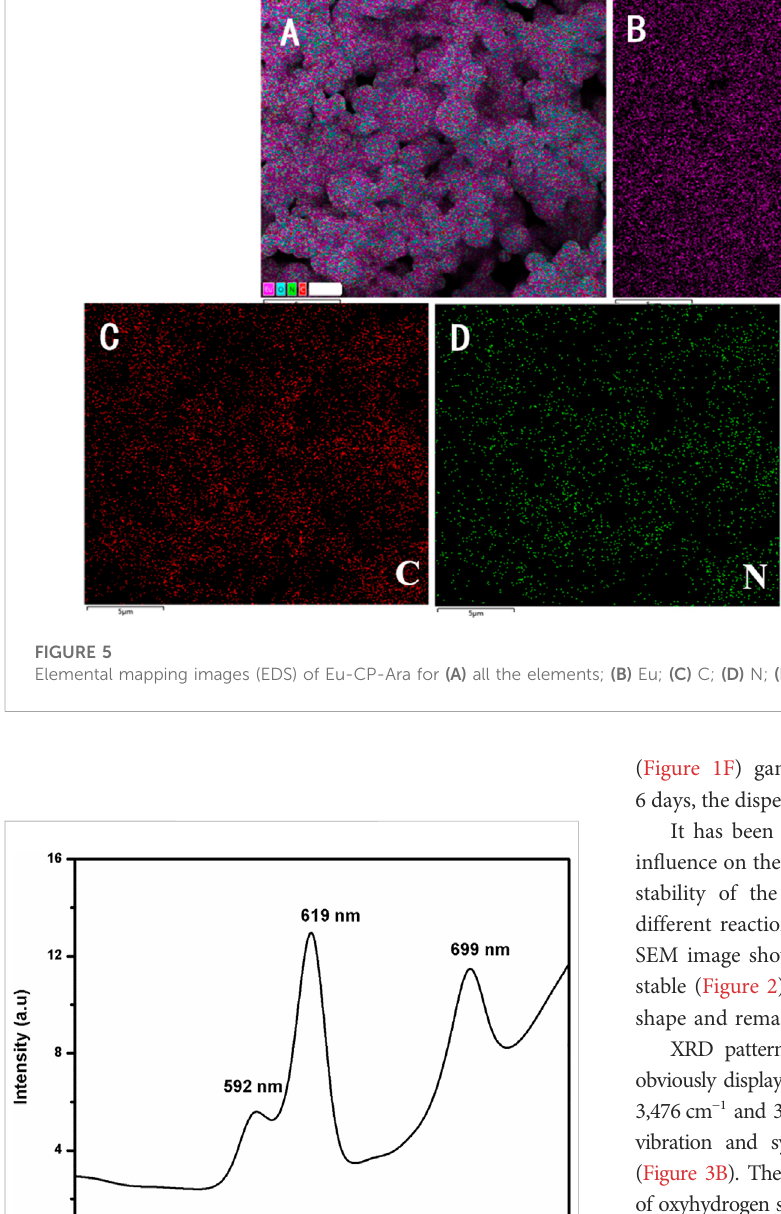
FIGURE 6 Emission spectra of Eu-CP-Ara particles under 394 nm